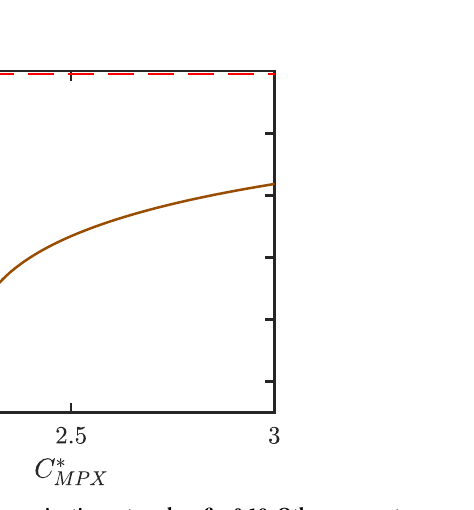
Fig 16. Optimal voluntary vaccination rates when β = 0.18. Other parameters are as in Table 1 unless they vary or are otherwise specified. The lines are color coded corresponding to the regions shown in Fig 10 which shows a diagram for Nash equilibria as e and C � vary. Blue: 0 is the only NE and it is CSNE. Brown: positive ψ MPX NE and it is CSNE. Red dashed line shows the value of ψ HI . Light blue shows a backward bifurcation when there are three NE at the same time. The full lines are CSNE, the dotted line is not.